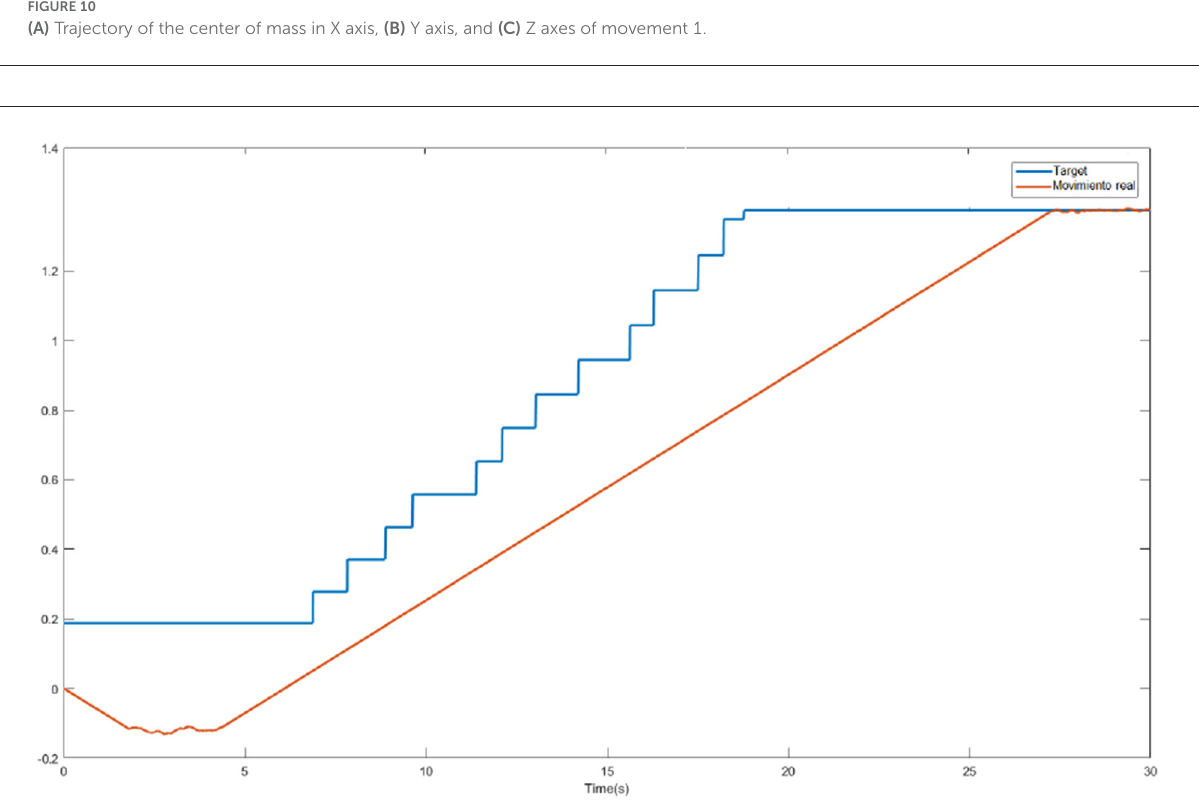
FIGURE11 Comparison of desired move (blue) with performed movement